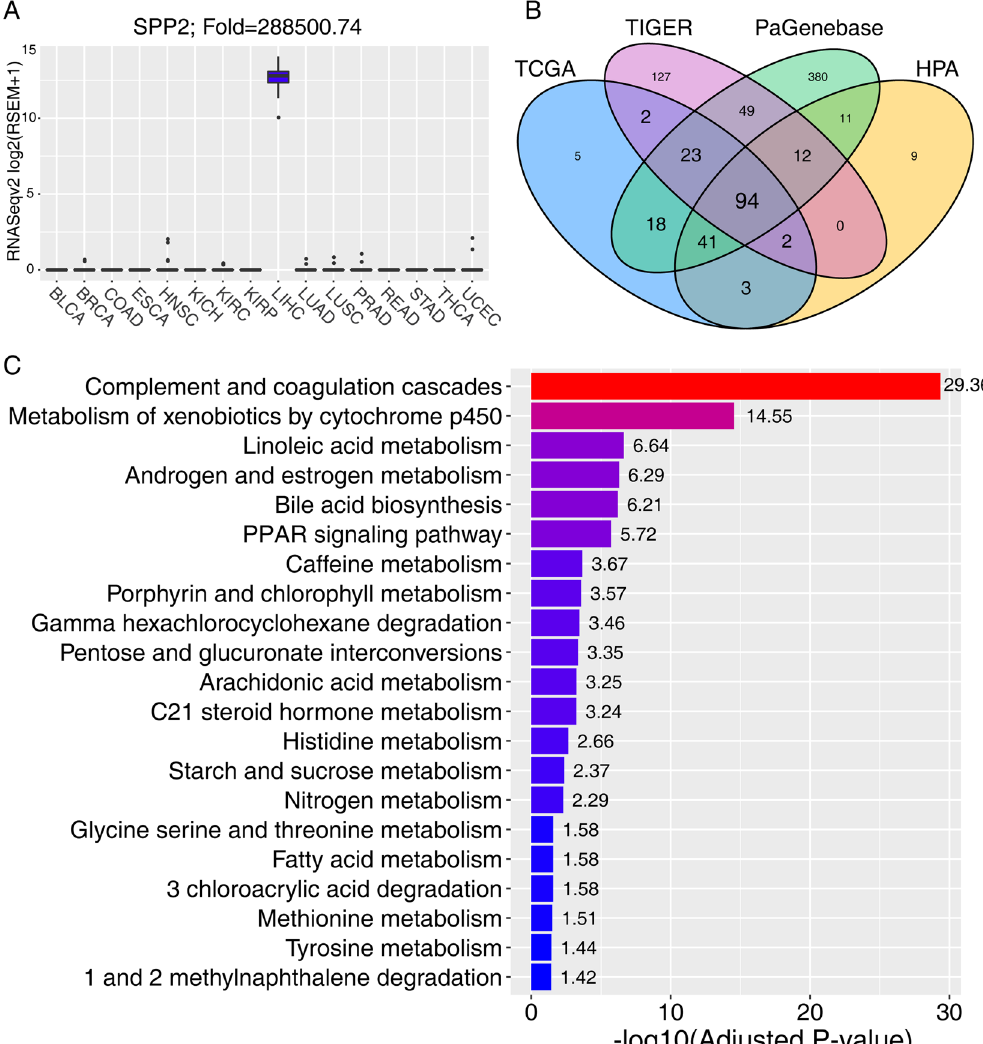
Figure 3. Validation of liver-enriched genes and KEGG analysis. ( A ) An example of liver-enriched genes. SPP2 was exclusively expressed in the corresponding non-tumor tissues of HCC. ( B ) Four-set Venn diagram showing the overlap of the liver-enriched genes derived from the TCGA and three other databases, including HPA, PaGenBase and TiGER. ( C ) Significantly enriched KEGG pathways of 188 liver-enriched genes. − log10(adjusted p-value) was annotated on each bar of the KEGG